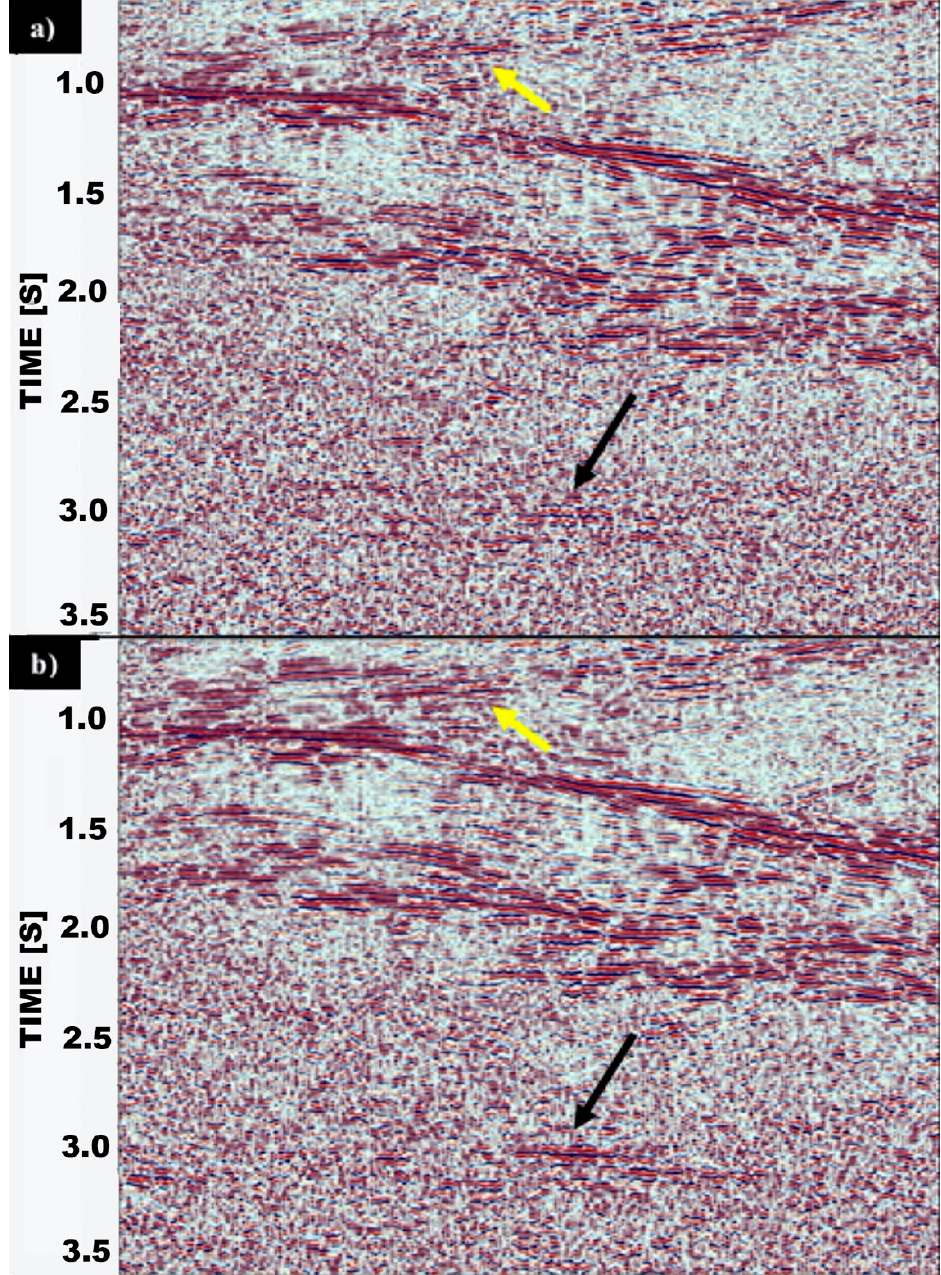
Figure 7. A comparison of the seismic section of Mesozoic sediments before ( a ) and after ( b ) filtering application.